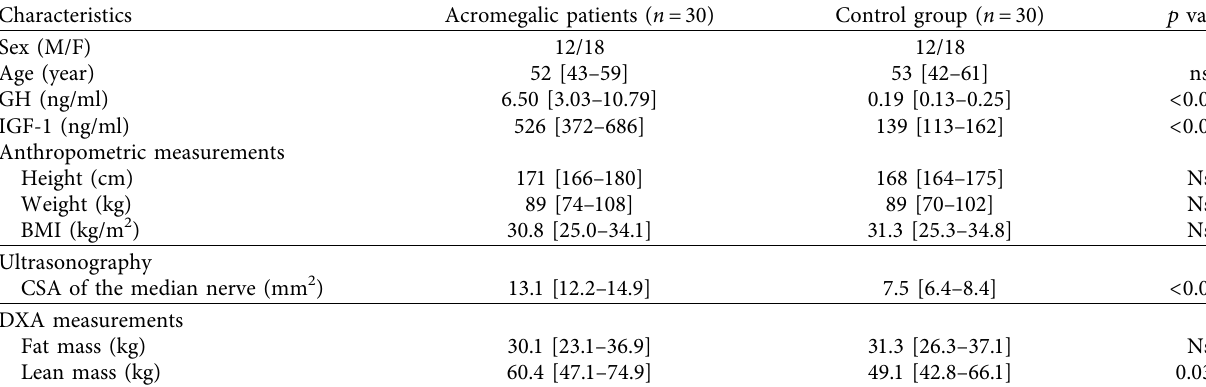
Table 1: Baseline characteristics of